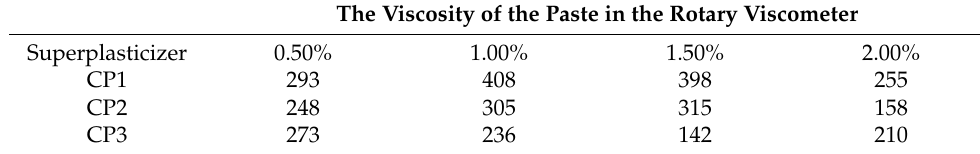
Table 5. The viscosity of the paste in the rotary viscometer. The Viscosity of the Paste in the Rotary Viscometer Superplasticizer